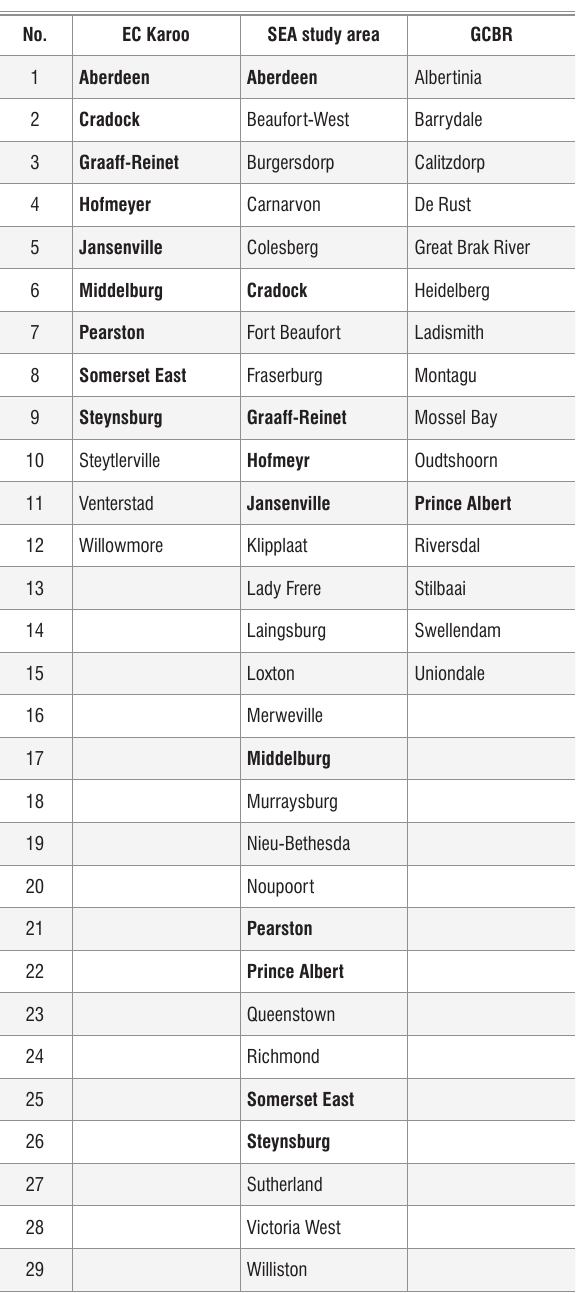
The towns of the Eastern Cape Karoo (EC Karoo), the strategic environmental assessment (SEA) study area and the Gouritz Cluster Biosphere Reserve (GCBR). Towns that fall into two of the three regions are indicated in